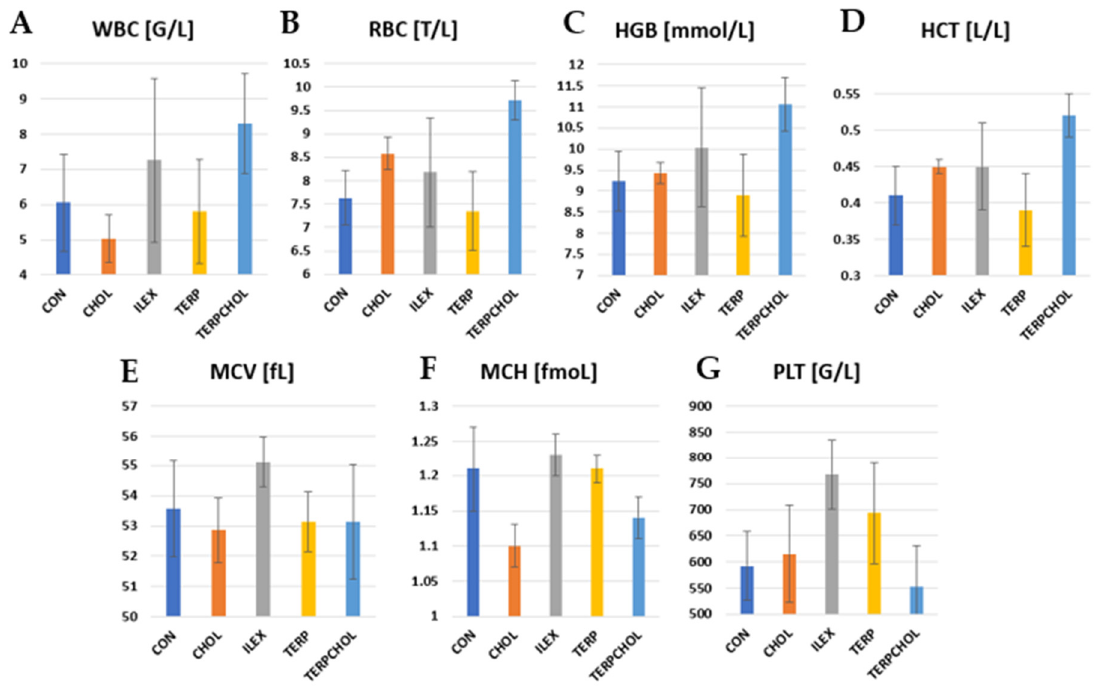
Figure 2. Level of ( A ) WBC, ( B ) RBC, ( C ) RBC, ( D ) HCT, ( E ) MCV, ( F ) MCH, and ( G ) PLT in CON, CHOL, ILEX, TERP, and TERPCHOL groups.